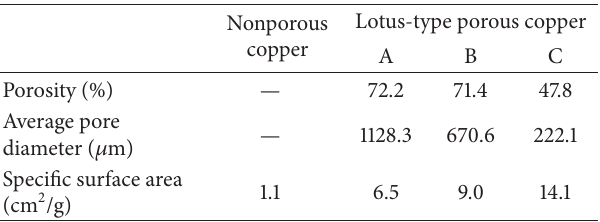
Table 1: Porosity, average pore diameter, and specific surface area of nonporous and lotus-type porous copper